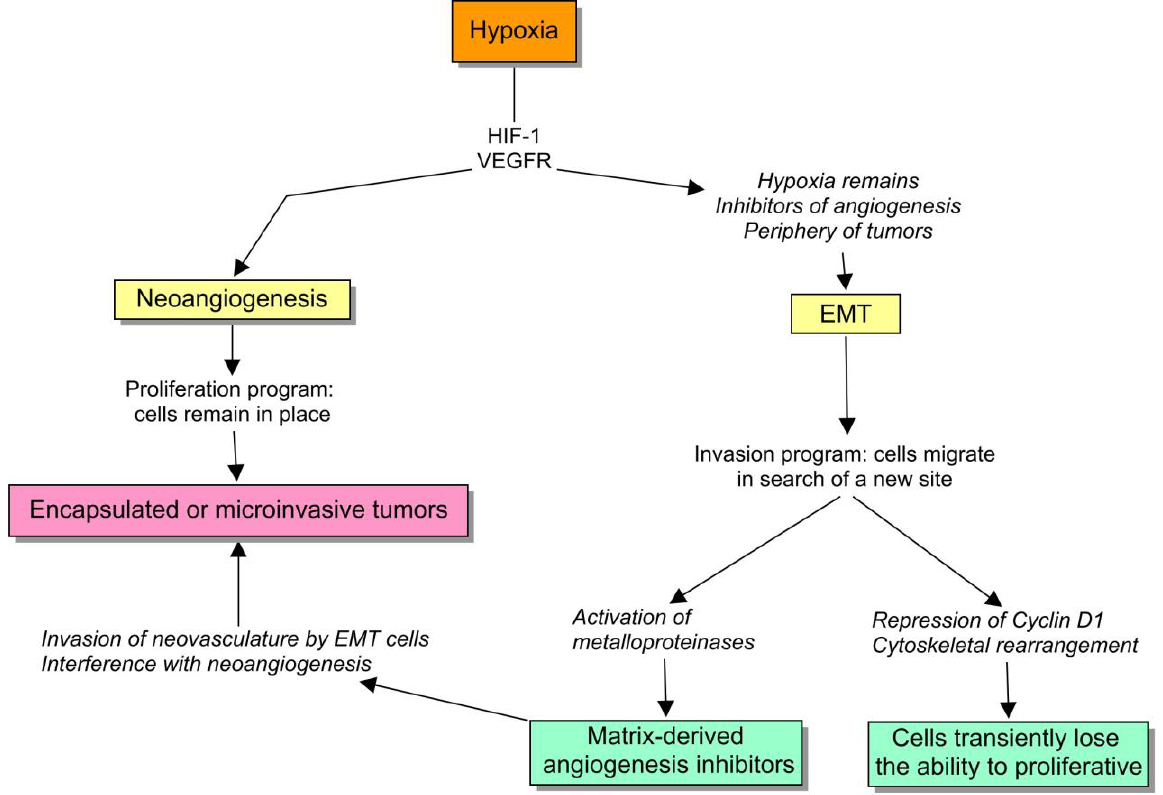
Figure 3. Environmental pressures contribute to make the choice between neoangiogenesis and EMT. The balance between both processes is a suitable target for natural selection, operating at the somatic